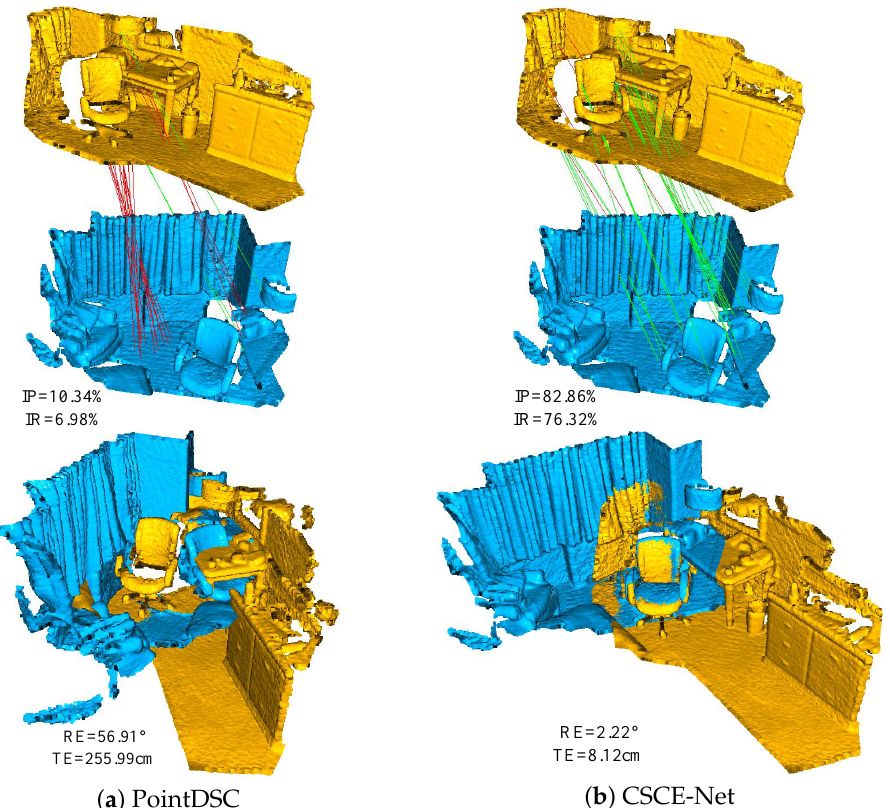
Figure 1. Visualization results of outlier rejection (top row) and pose estimation (bottom row) for pairwise point clouds in indoor scenes. IP/IR and RE/TE indicate inlier precision/inlier recall and rotation error/translation error, respectively. ( a ) The popular network PointDSC [15] with weak contextual features retains many outliers and obtains significant alignment errors in pairwise point clouds with slight overlaps resulting in registration failures. ( b ) CSCE-Net extracts richer contextual features and retains more inliers in pairwise point clouds that overlap less, significantly reducing alignment errors and achieving accurate point cloud